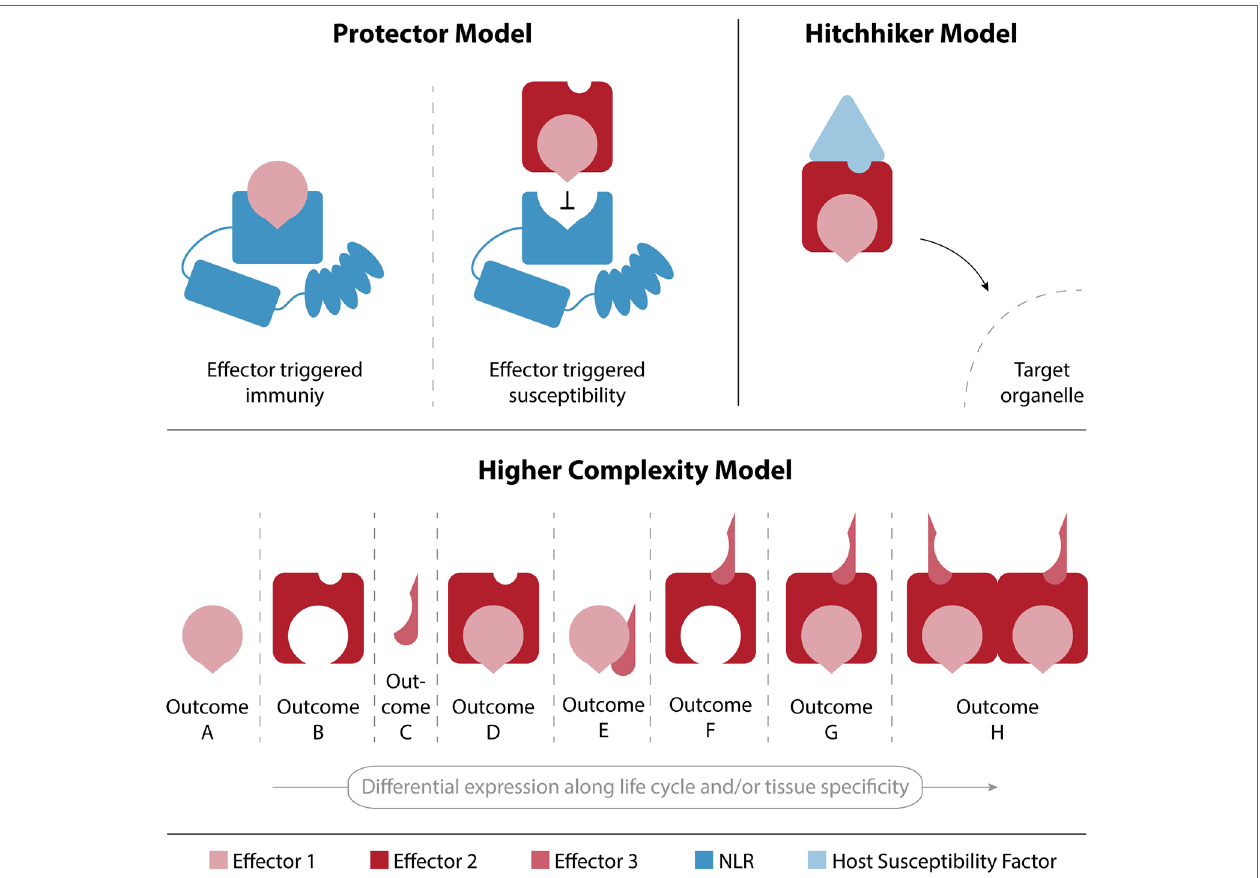
FigURE 3 | Models for effector-effector interaction outcomes. The protector model describes an interaction between effectors 1 and 2, which results in the avoidance of recognition of effector 1 by the plant’s immune system and therefore leads to a successful infection. In the hitchhiker model, effector 1 is able to shuttle to its target organelle by interacting with effector 2, which in turn interacts with a plant susceptibility factor that mediates the shuttling upon effector binding. The higher complexity model highlights the plasticity that can emerge by differential effector expression along the pathogen’s lifecycle and/or in specific